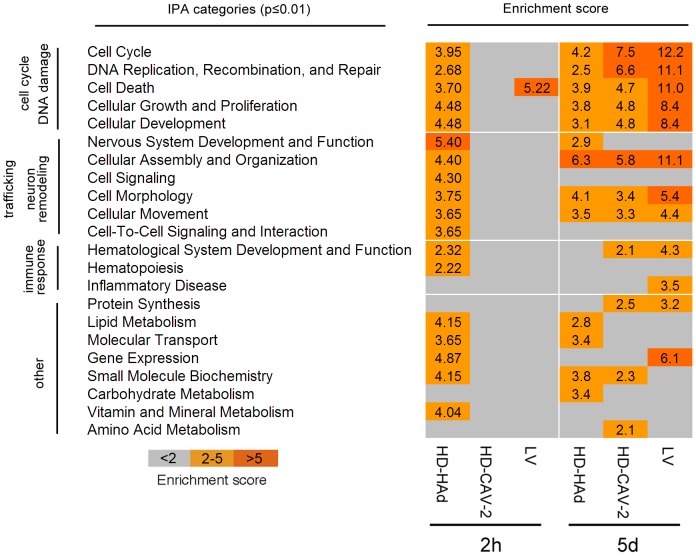
Functional gene categories significantly enriched by HD-HAd, HD-CAV-2 and LV.Data sets containing the Affymetrix probe identifiers selected as differentially expressed in transduced cells and the corresponding fold changes were uploaded onto IPA. Significant molecular and physiological functions were determined querying the IPA Knowledge Base and selecting a scoring method based on the Fisher's exact test applying the threshold of p-value≤0.01. Significantly enriched IPA categories containing at least 10 genes are listed and the relative score is indicated. Categories were further manually classified into four groups: i) cell cycle and DNA damage, ii) trafficking and neuron remodeling and iii) immune response, iv) other.